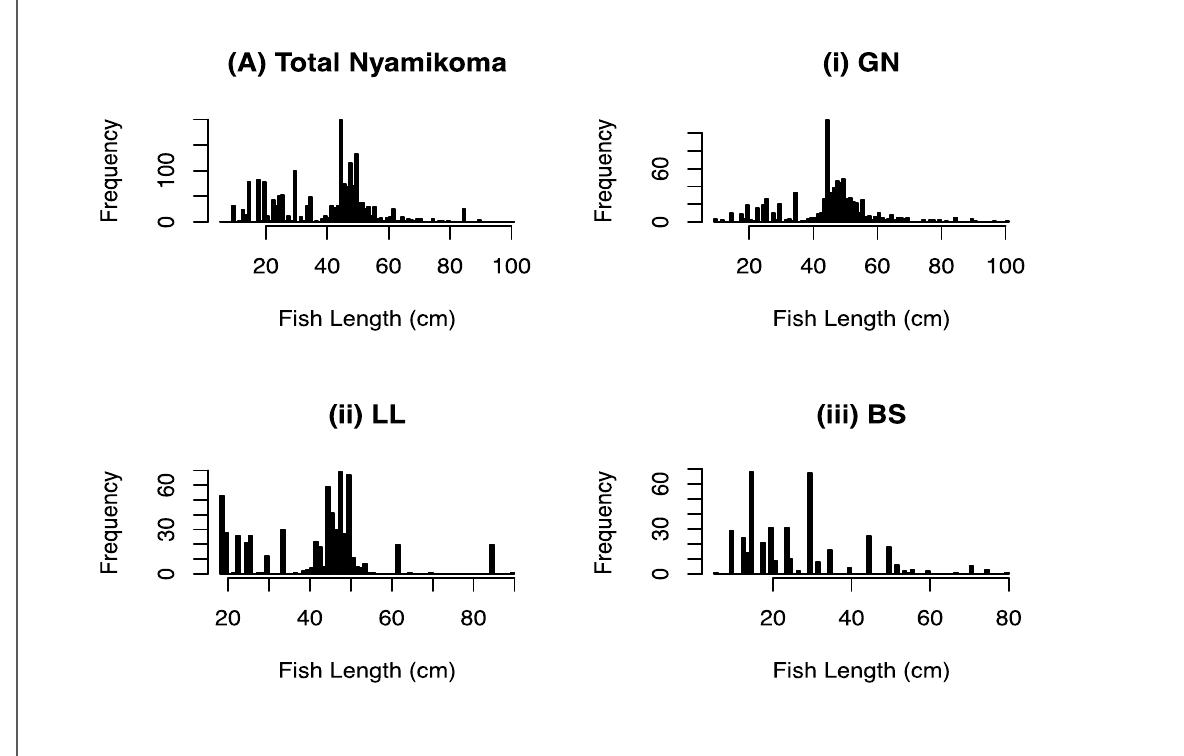
Figure 4: Length frequency of Nile perch for each fishing gear at three different landing sites (A) Nyamikoma, (B) Ihale (C) Nyakaboja, (D) data collected for two months at Magu district in Lake